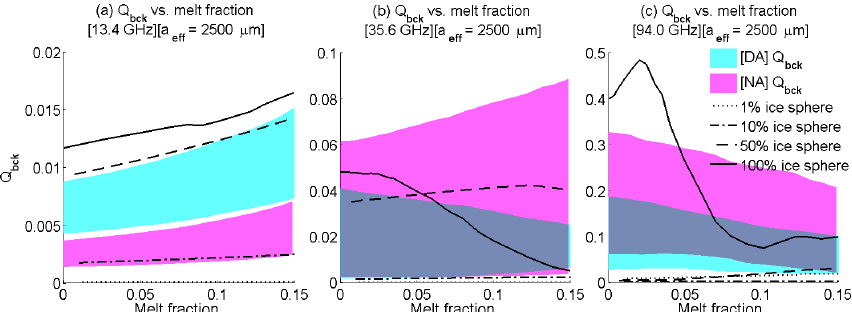
Figure 7. Same as Fig. 6 except at 2500-micron effective radius. The needle aggregate at 35GHz has a very large range due to parti- cle rotation, whereas the dendrite aggregate exhibits about half the same range. Similar to Fig. 6c, the needle aggregate exhibits a larger backscattering compared to the dendrite aggregate efficiencies at 35.6 and 94GHz. Panel (a) shows behavior consistent with spheres; how- ever, in (b) 35.6 and (c) 94GHz there is no consistent behavior. Note that the backscattering efficiency in panel (b) for DA (blue region) is completely encompassed by NA, and there is significant overlap between the two in panel (c) .